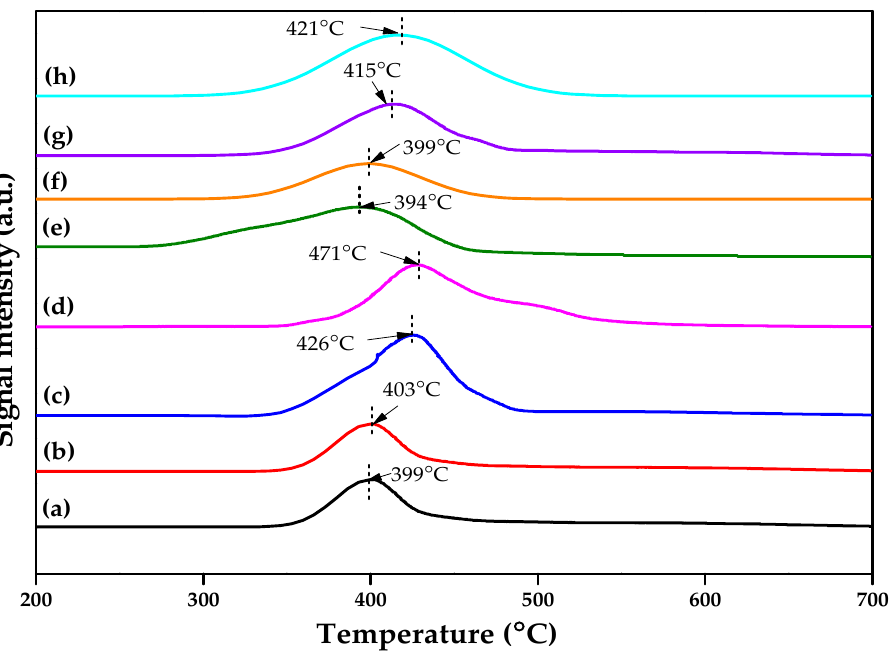
Figure 4. H 2 -TPR profile of ( a ) 10%Ni/ZrO 2 _WI, ( b ) 10%Ni-0.5%Ca/ZrO 2 _WI, ( c ) 10%Ni- 3%Ca/ZrO 2 _WI, ( d ) 10%Ni-5%Ca/ZrO 2 _WI, ( e ) 10%Ni/ZrO 2 _Us, ( f ) 10%Ni-0.5%Ca/ZrO 2 _Us, ( g ) 10%Ni-3%Ca/ZrO 2 _Us, and ( h ) 10%Ni-5%Ca/ZrO 2 _Us catalysts.